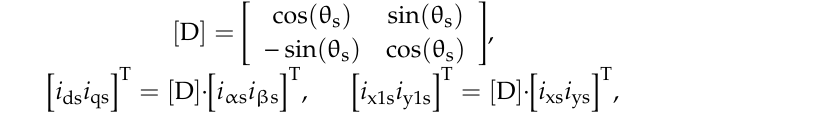
Figure 2. Voltage vectors in α - β (left plot) and x - y (right plot) subspaces for an asymmetrical six-phase IM drive.